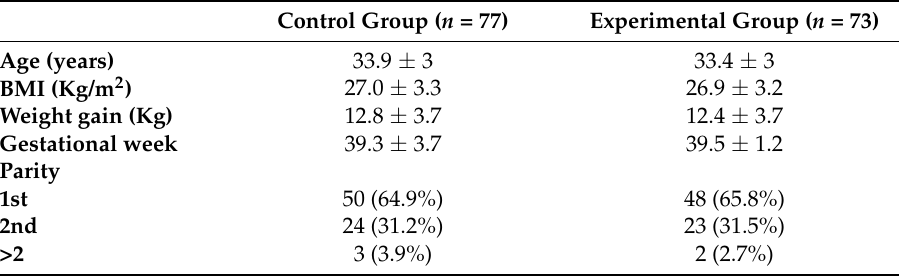
Table 2. Obstetrical features of parturients in the study and control groups.